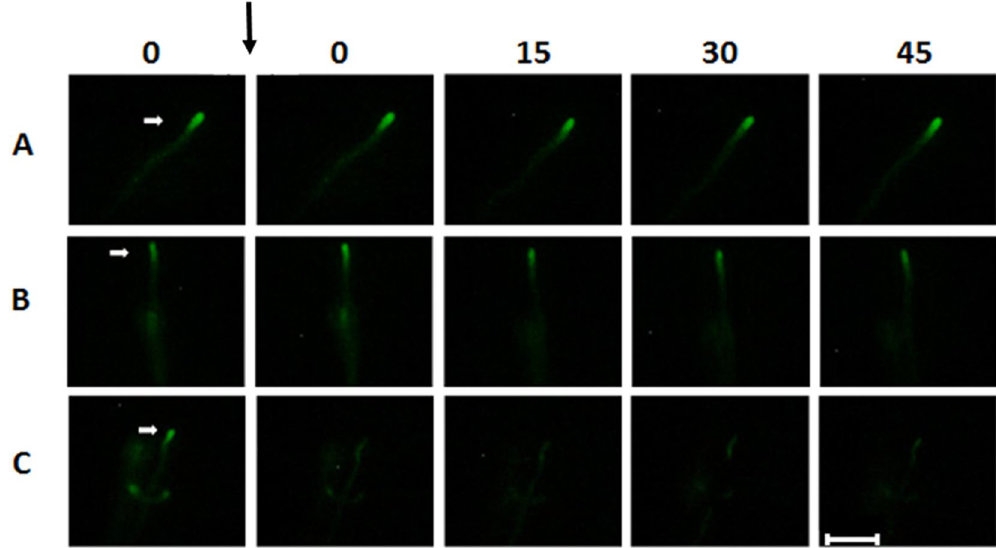
Figure 1. Fluorescently labelled Spitzenkörper before and after dissection in the 2nd compartment in a control hypha ( A ), a hypha continuing ( B ) and a hypha stopping growth ( C ) after dissection. Numbers indicate the time after laser dissection. White arrows denote the tip for which fluorescence was recorded. The black arrow indicates the moment of cutting. Bar represents 25 µ